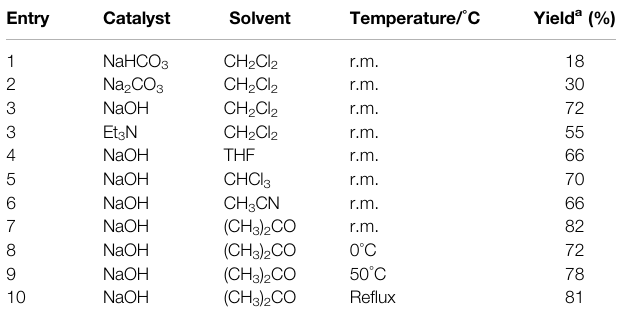
TABLE 1 | Reaction conditions for intermediate Ⅱ were optimized.